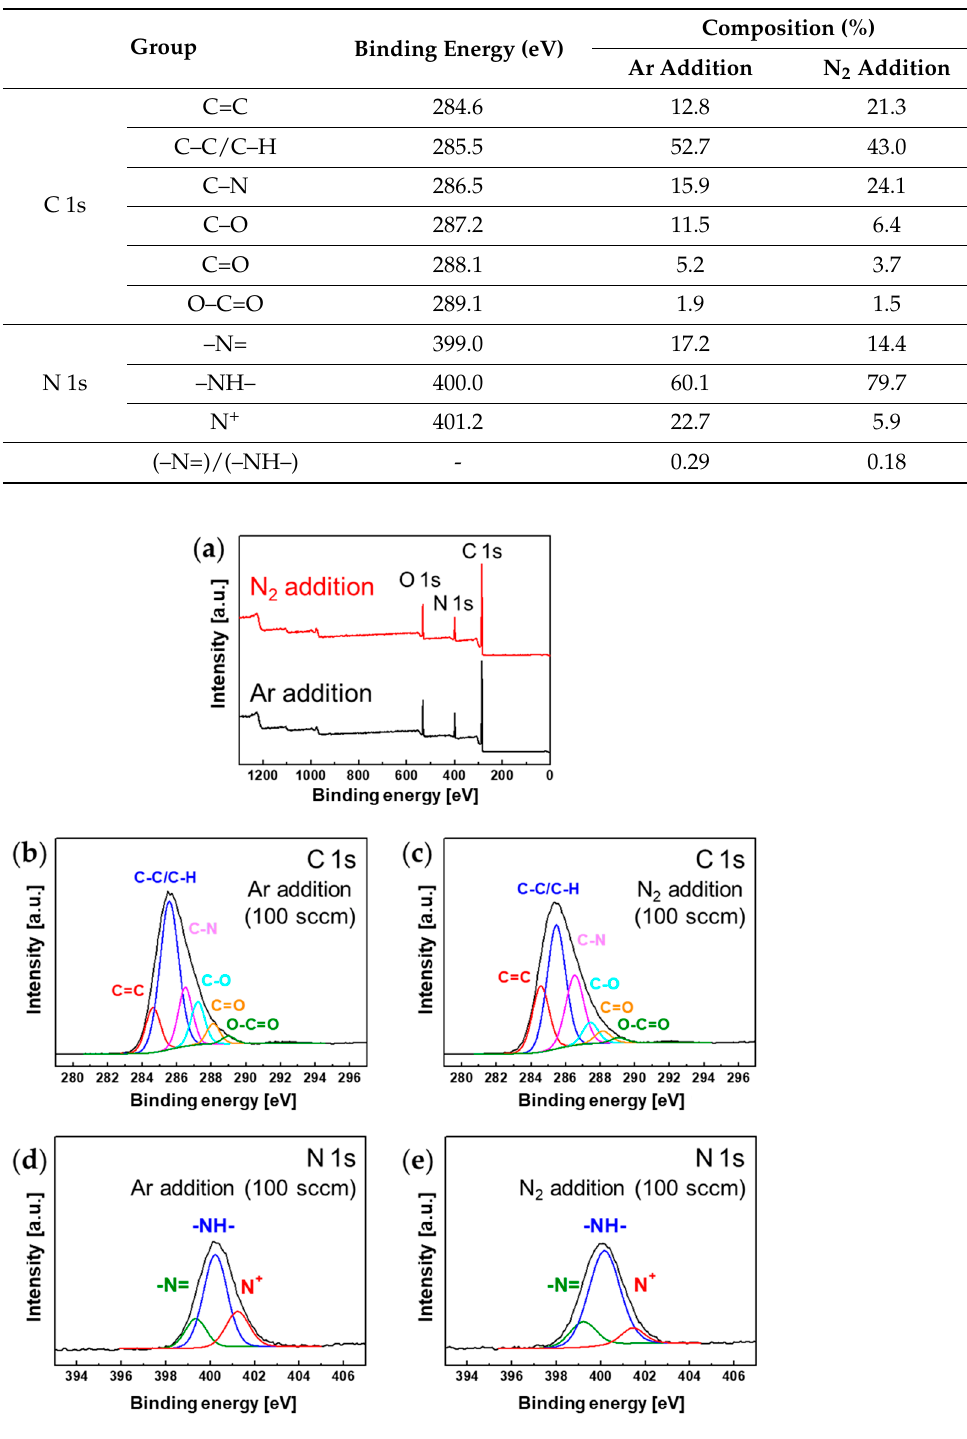
Figure 8. ( a ) Wide-scan XPS spectra of PANI films synthesized with additional gases (Ar and N 2 ). ( b , c ) C 1s core-level spectra of PANI films synthesized with Ar and N 2 gases. ( d , e ) N 1s core-level spectra of PANI films synthesized with Ar and N 2 gases. Table 1. Surface atomic composition ratios of PANI fi lms synthesized with additional gases (Ar and N 2 ).